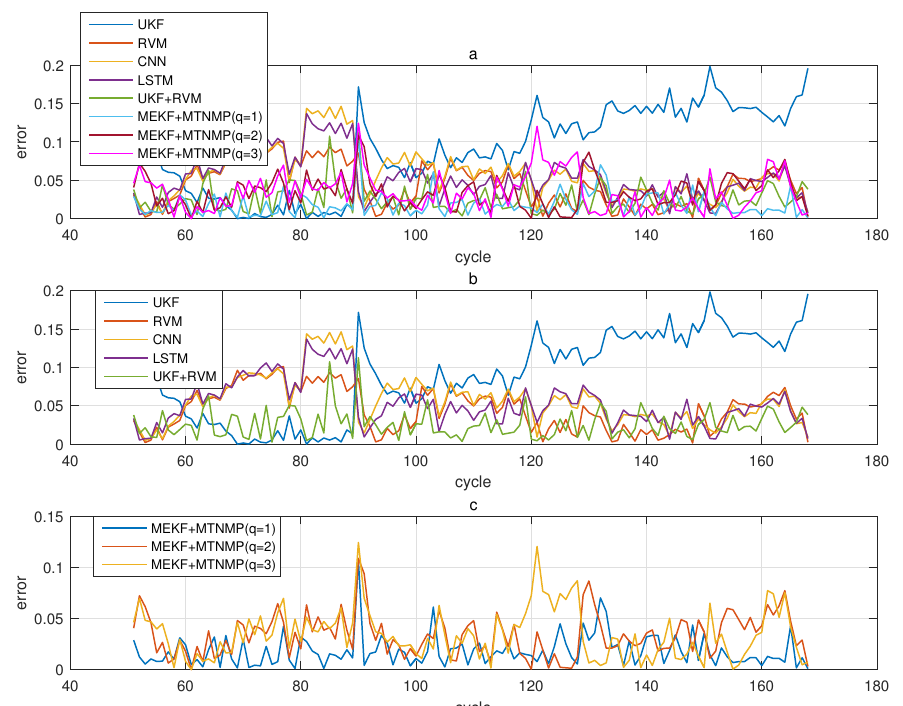
Figure 9. The simulation error diagram of B0006 predicted from the 50th time. ( a ) is the experimental error of all methods, ( b ) is the error of other methods used for comparison in ( a ), and ( c ) is the error of the method proposed in this paper in ( a ).